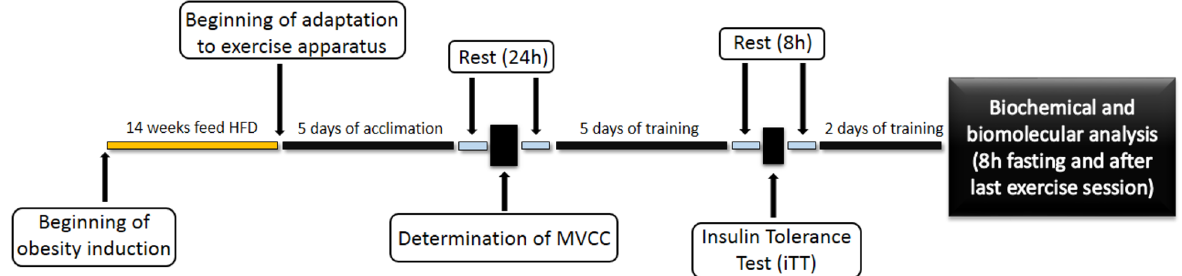
Figure 7. Experimental design. Schematic representation of the duration of the